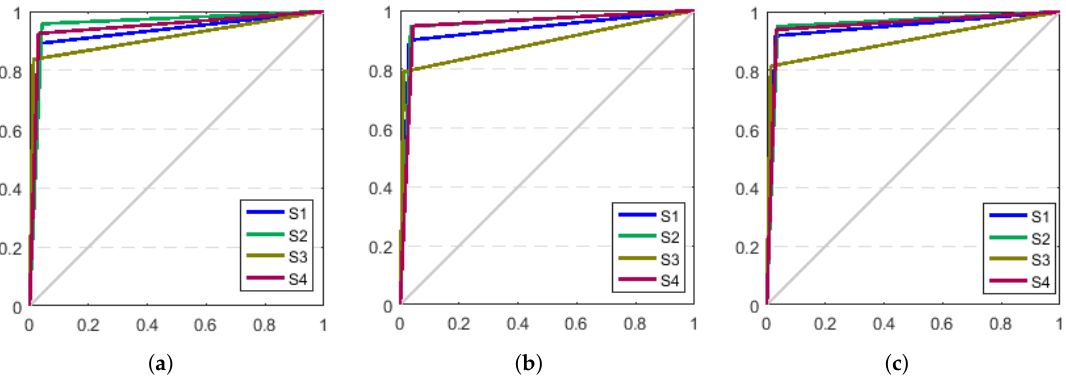
Figure 15. ROC curve of HMM parameters before and after adaptation ( a ) HMM ( b ) MLLR ( c )